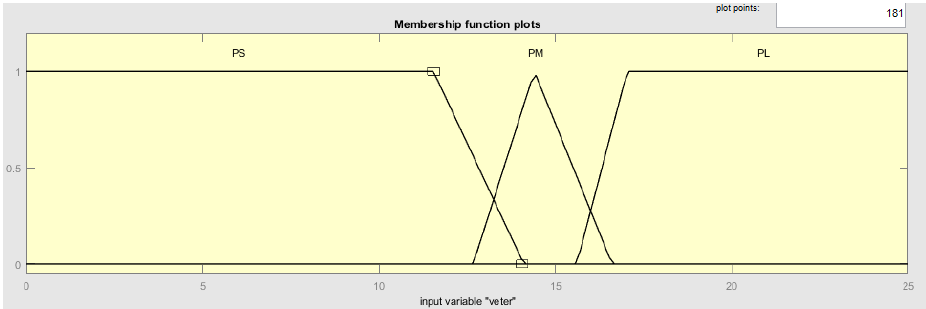
Figure 9. Membership functions of the input variable “power gradient”.